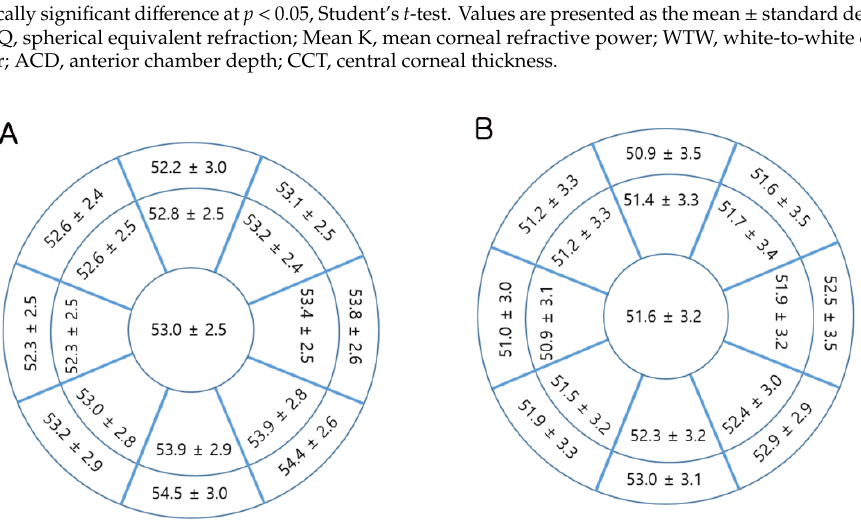
Figure 1. Topographic corneal epithelial thickness map for ( A ) male children ( n = 122) and ( B ) female children ( n = 201).